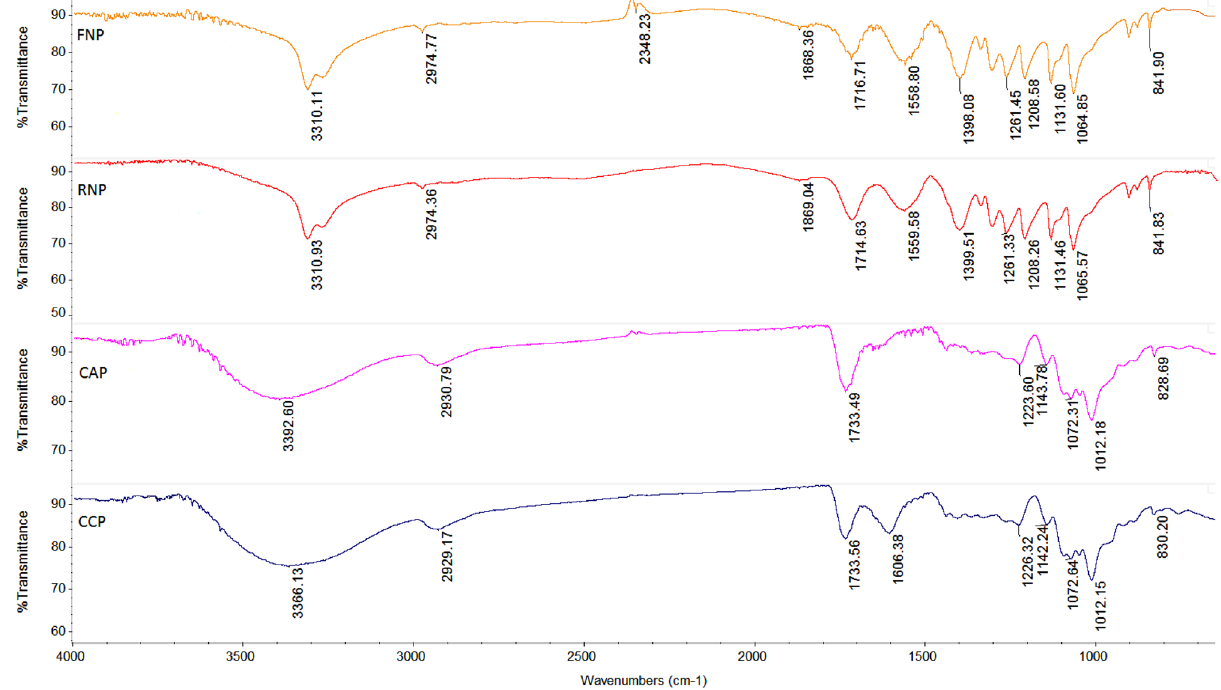
Figure 3. FT-IR spectra of pectin extracted from grape pomace (FN and RN) by MAE under the optimal conditions, commercial apple and citrus pectin (CAP and CCP).